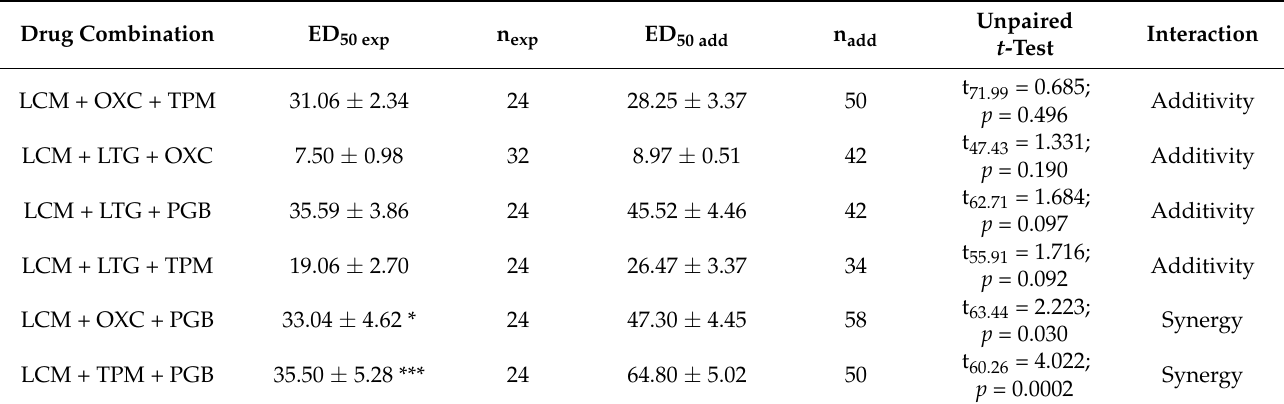
Table 1. Isobolographic analysis of interactions among three ASMs.